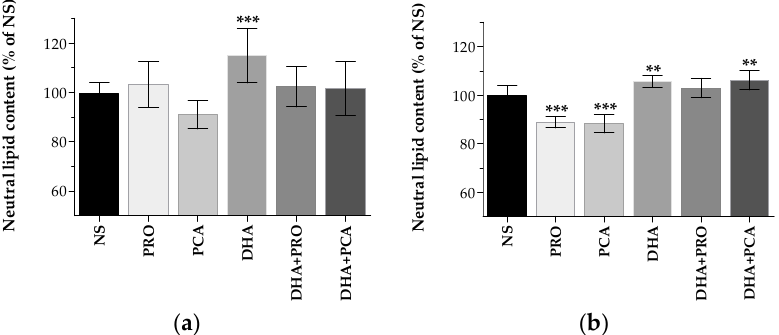
Figure 3. Lipid droplet accumulation in not supplemented (NS) and supplemented cells with docosahexaenoic acid (DHA), protocatechuic acid (PCA) and propionic acid (PRO), after ( a ) 6 h and ( b ) 24 h supplementation. Data in each group are means ± standard deviation (SD) of five samples derived from two independent experiments. Neutral lipid content is expressed as the percentage of the value obtained in NS cells (assigned as 100%). Statistical analysis was carried out by one-way ANOVA (panels ( A , B ) p < 0.001) using Dunnett’s post-test to compare NS and supplemented cells (** p < 0.01; *** p < 0.001).